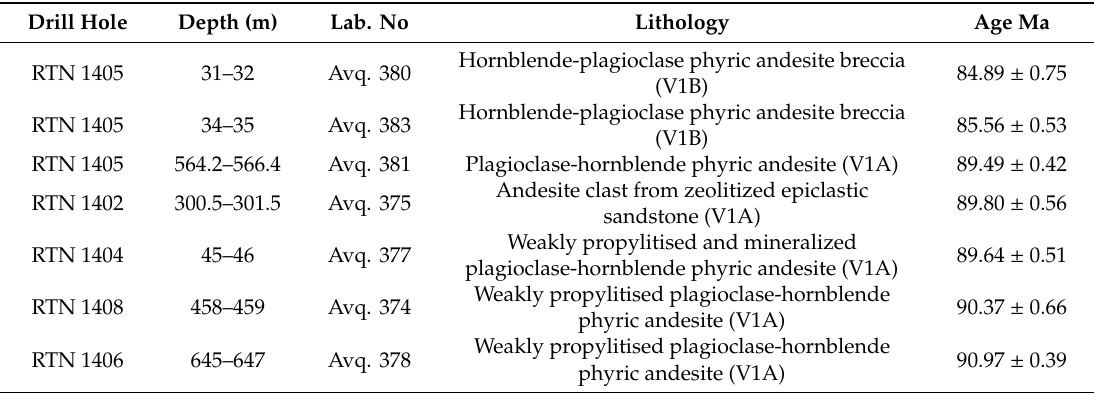
Table 2. U / Pb zircon ages of samples of V1A and V1B andesite units from Nikoliˇcevo. The ages are calculated as weighted 206 Pb / 238 U mean